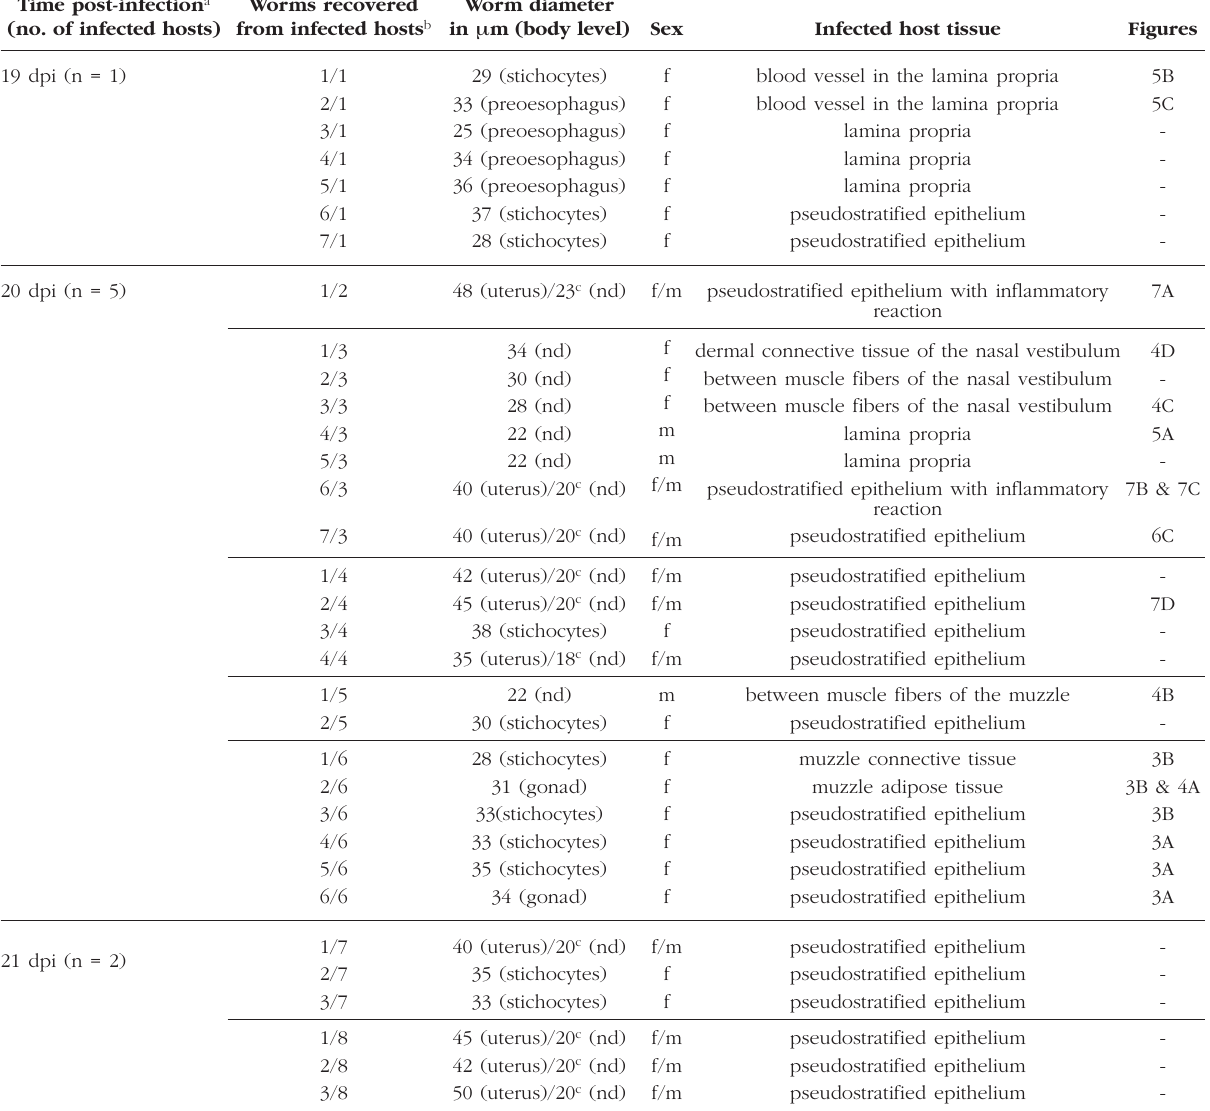
Table I. – Migration of Trichosomoides nasalis in intraperitoneally infected Arvicanthis niloticus : worm localization (n = 33) in the anterior part A of the maxilla (see Fig.